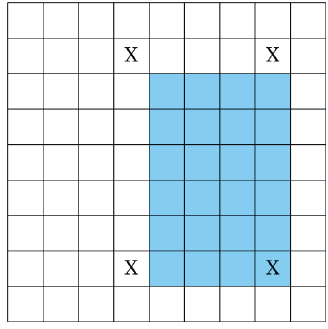
Figure 14. Box filter calculation using the integral image; the shaded area indicates the filter to be computed whereas ‘X’ shows the integral image values required for computation of this box